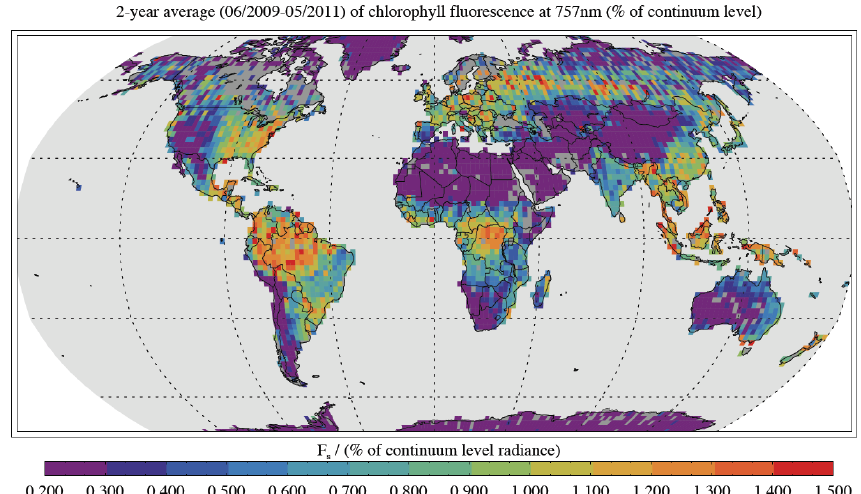
Fig. 1. 2-yr average of retrieved chlorophyll fluorescence at 757nm, retrieved and corrected according to Frankenberg et al.